Question: Name the type of graph shown.
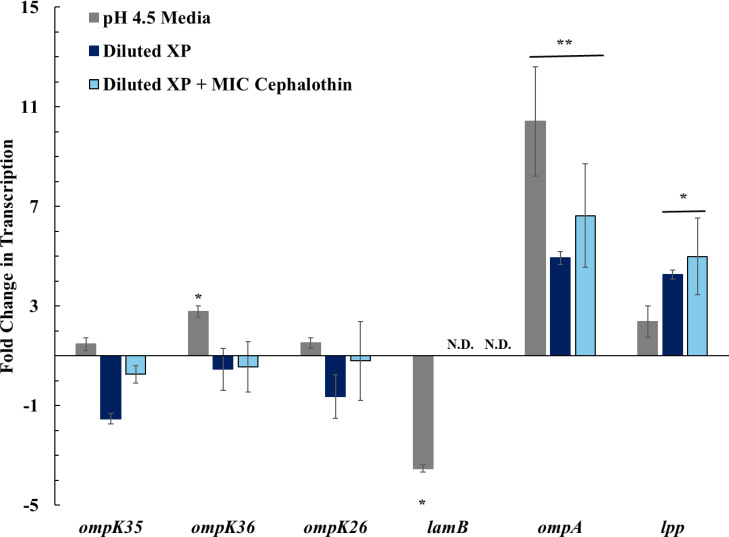
Answer: bar